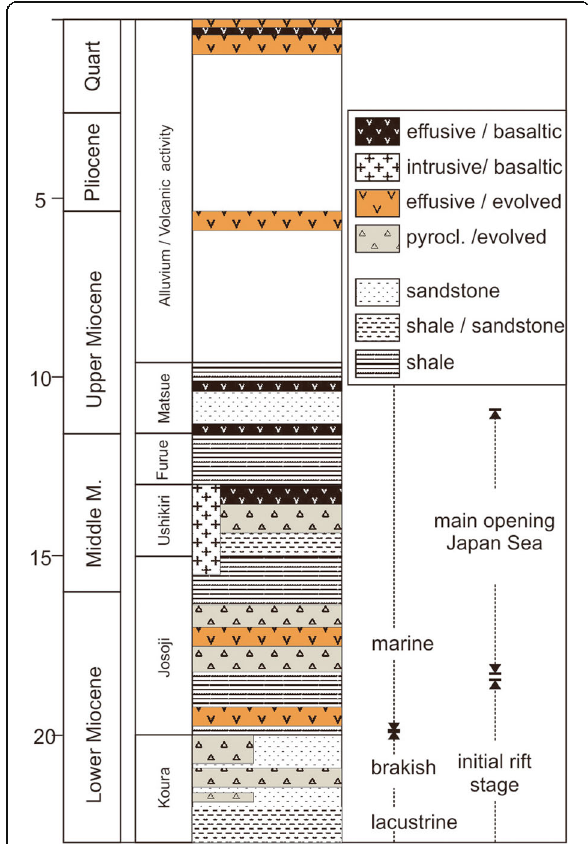
Fig. 8 Relationship between Miocene back-arc strata (Shimane Peninsula / Matsue area) and igneous activity in the back-arc region (Ishiga and Dozen 1997). Rift related submarine pyroclastic and intrusive successions are intercalated with terrigenous sediments. Post rifting activity is marked by monogenetic volcanism (12 Ma – recent) and arc volcanism (3 Ma -